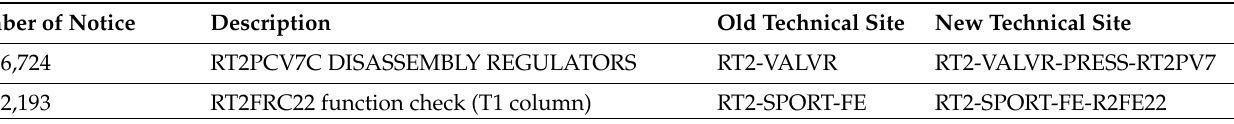
Table 7. Example of reconstruction data applying the fifth